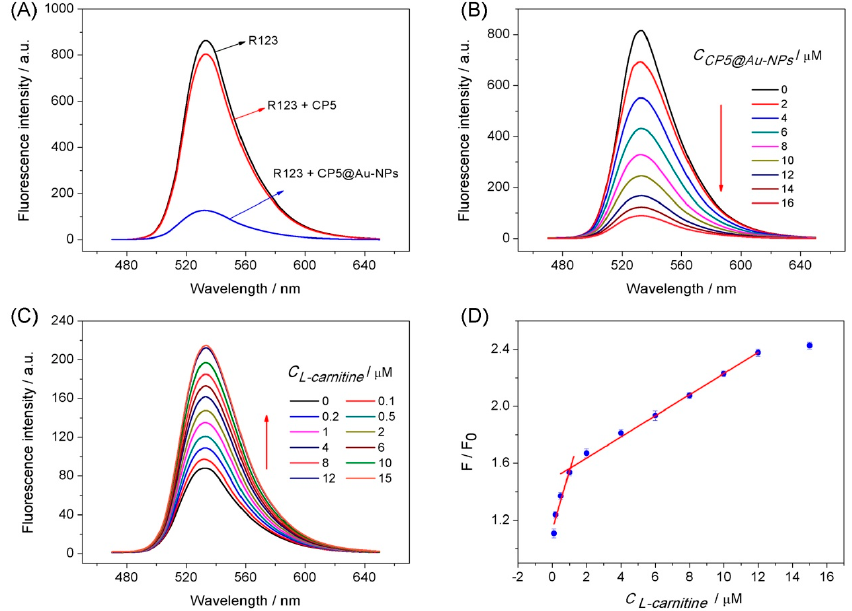
Figure 3. The fluorescence intensity of 2 μ M R123 in the presence of 10 μ M CP5 and 16 μ M